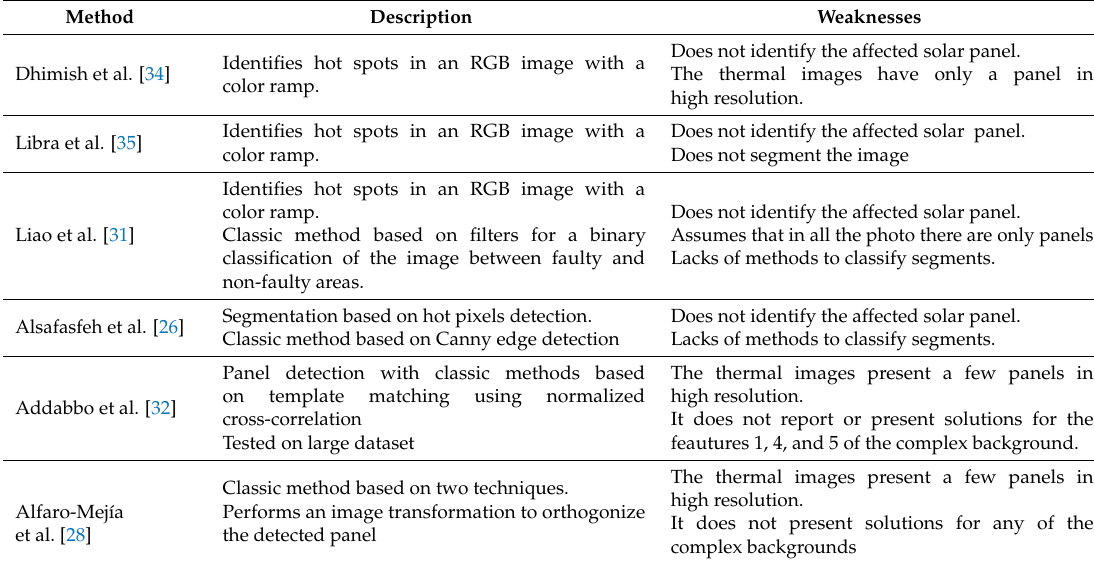
Table 1. Comparison between the proposed method and other research identifying solar panels using only thermal images with a complex